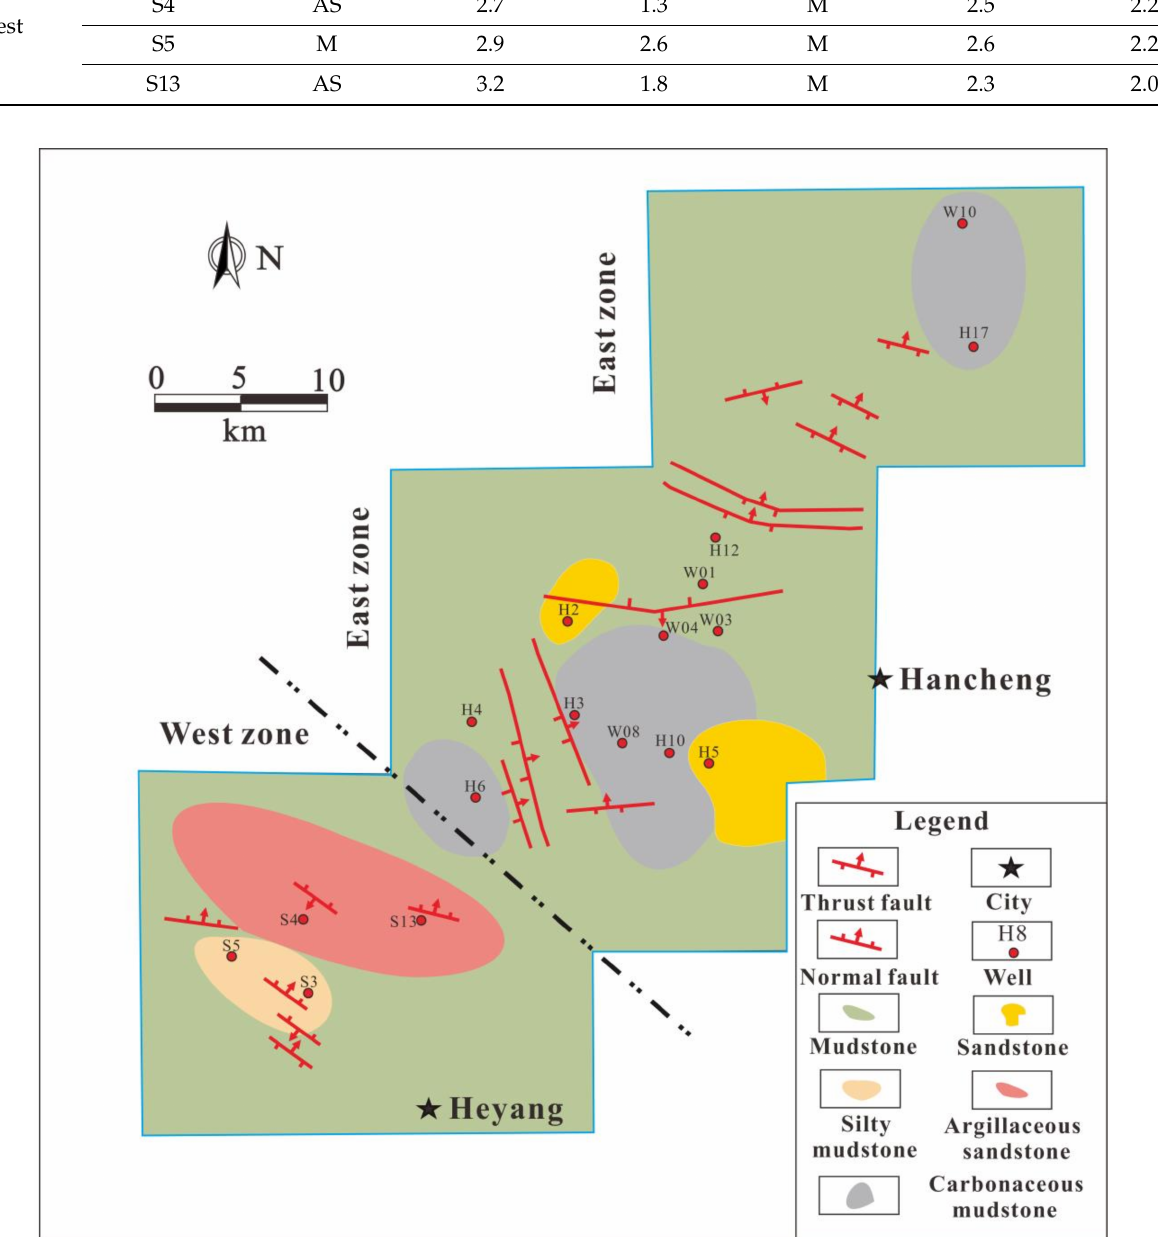
Figure 5. Roof lithology distribution of the No.5 coal seam in the Weibei